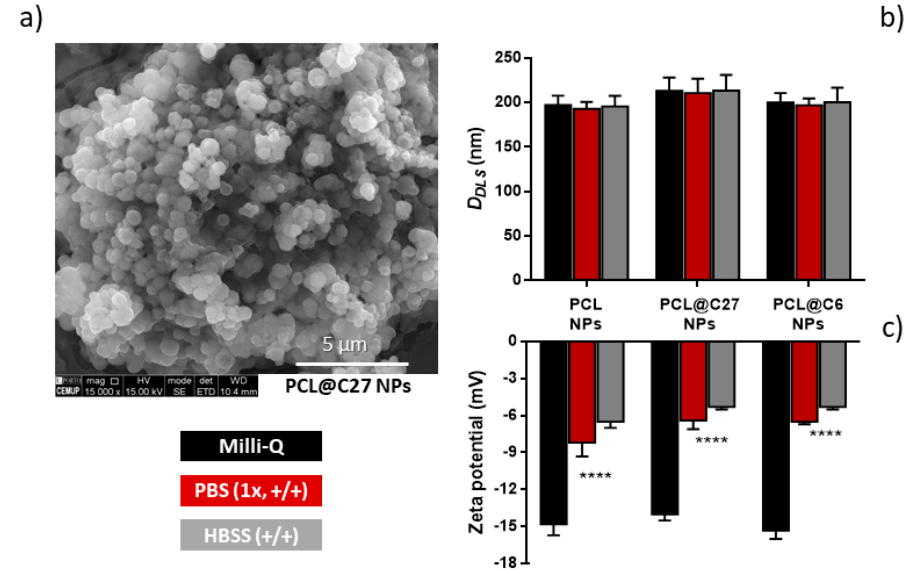
Figure 4. Morphological characterization of PCL@C27 NPs by scanning electron microscopy (SEM) ( a ) and hydrodynamic average sizes (D DLS ) ( b ) and zeta potential values ( c ) of PEGylated PCL NPs in Milli-Q water, phosphate buffered saline solution (PBS) (1×, +/+), and Hank’s balanced salt solution (HBSS) (+/+), as measured by dynamic light scattering (DLS). All measurements were performed in triplicate and results are given as mean ± SD. Statistical comparisons were made using two-way ANOVA. In all cases, p -values lower than 0.05 were considered significant (**** p < 0.0001 versus Milli-Q water values).